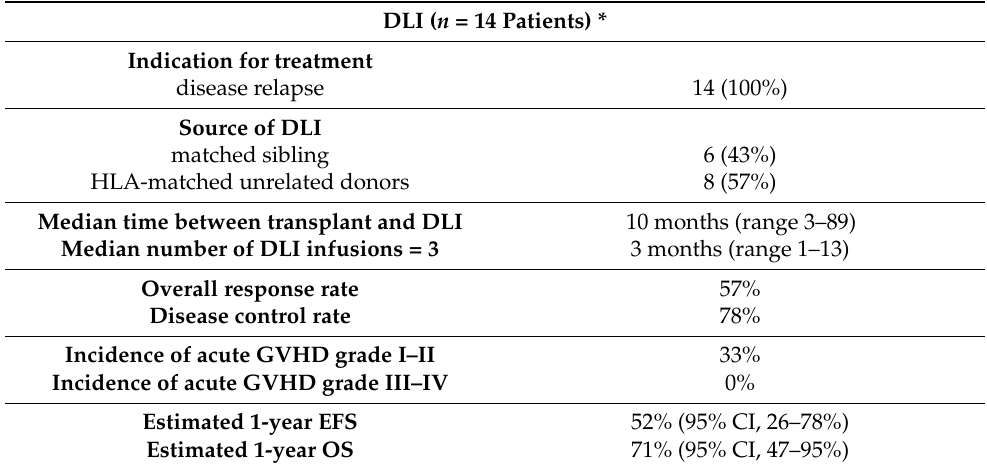
Table 4. Donor Lymphocyte infusions indications and